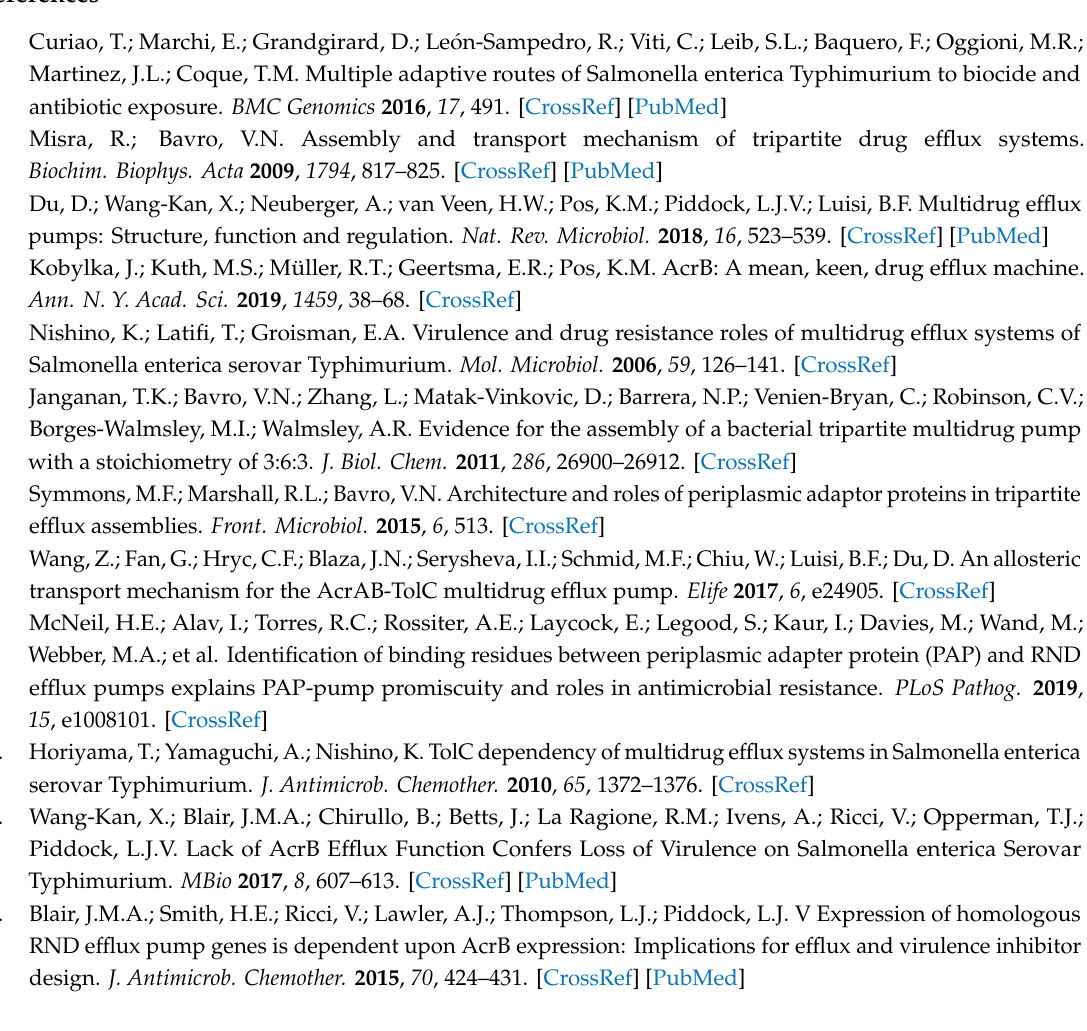
Figure S1. Protein RMSD calculated along the MD trajectories of S TmAcrB G288D aligned to the S TmAcrB WT ; Figure S2. Multiple sequence alignment of S TmAcrB G288D aligned to the S TmAcrB WT and Ec AcrB WT ; Table S1. Data collection, processing and model fitting statistics.; Table S2 Values of the Cross-Correlation Function obtained through Flex-EM for the homology models of S TmAcrB G288D , before and after the optimization inside the cryo-EM